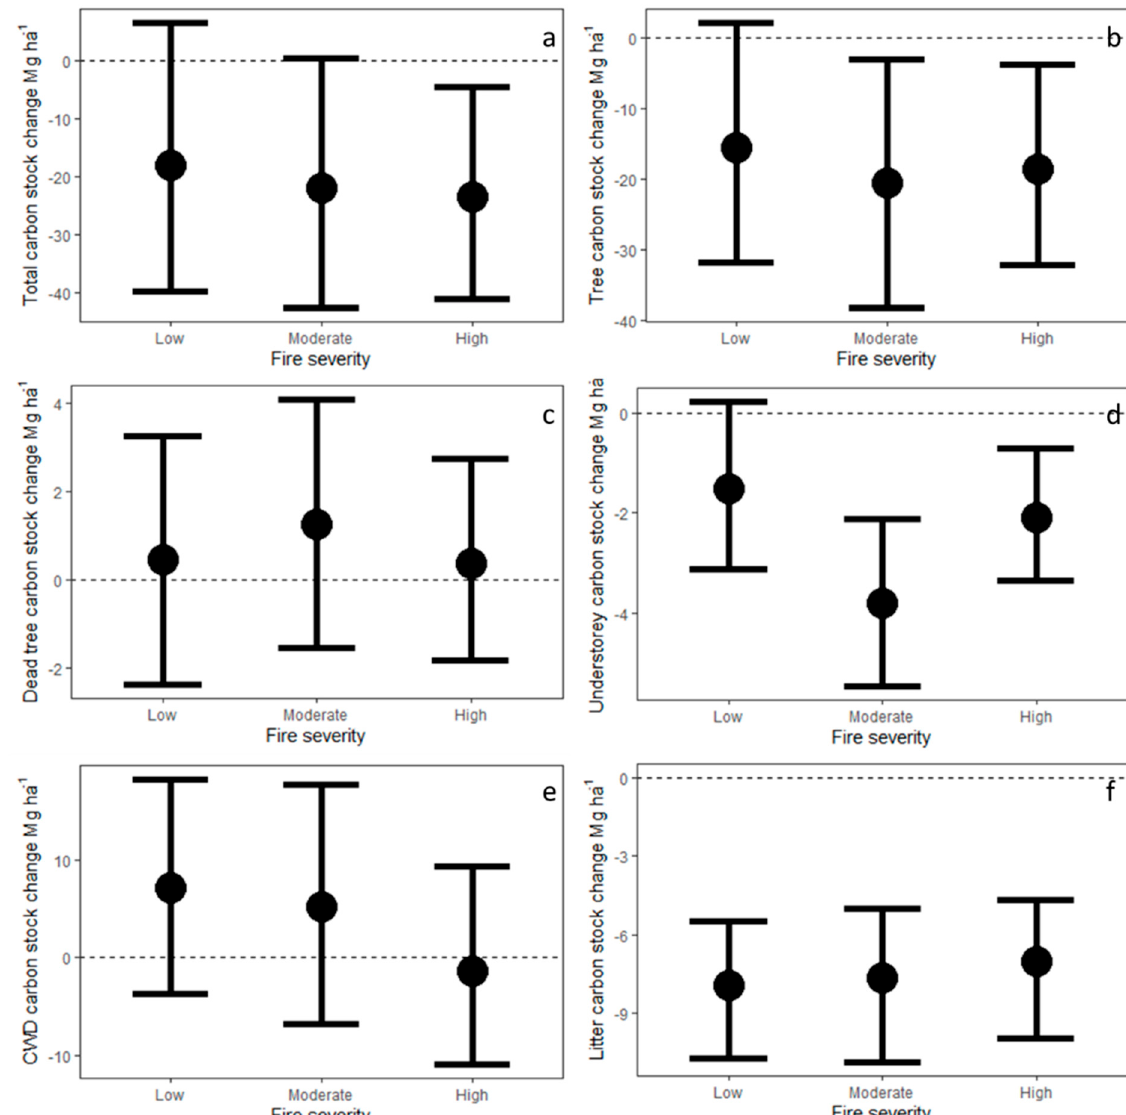
Figure 6. Change in total ( a ), live tree ( b ), dead tree ( c ), understorey ( d ), coarse woody debris ( e ) and litter ( f ) carbon stocks between the pre- and post-fire carbon surveys in response to the severity of the 2019–2020 wildfire. Central point and bounds indicate the median and 90% posterior density intervals respectively. Predictions were made with time since logging and time since fire fixed at 40 years, topographic position at ‘Slope’, time since hazard reduction at 10–35 years and all other variables at their mean.